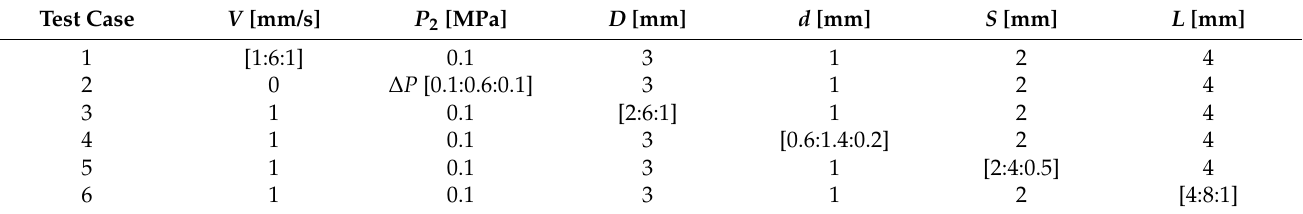
Table 1. Parameter Table 1. Parameter values.